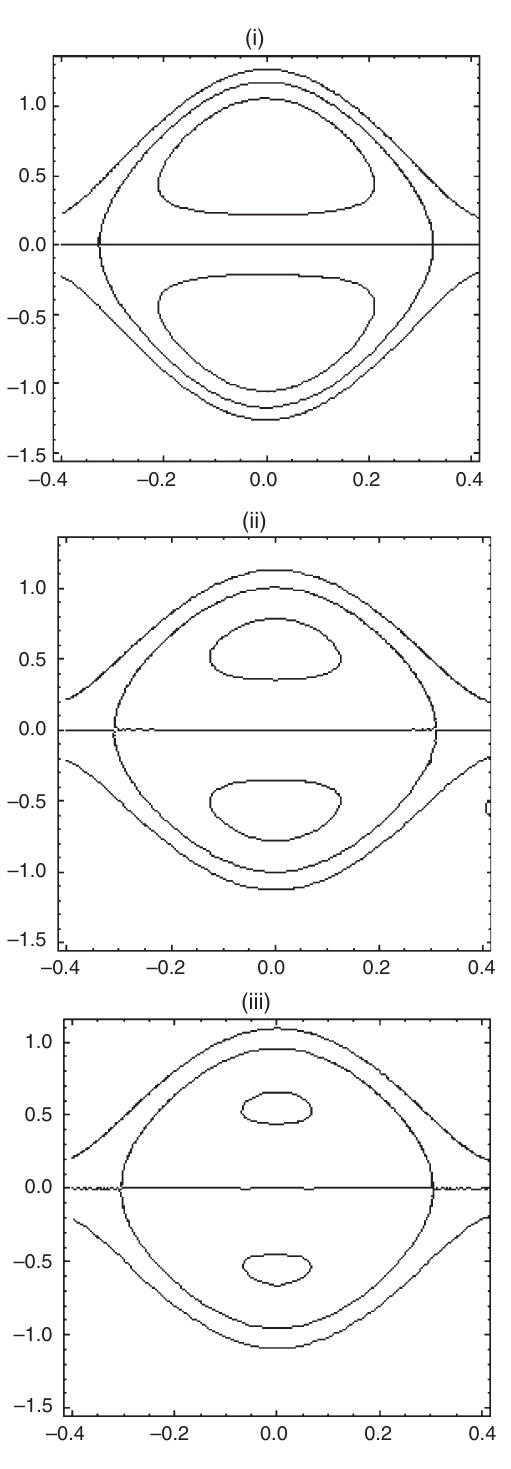
Fig. 10. Streamlines for a =0.5, b =0.5, d =1; Q = 1 . 4 and for dif- ferent β (i) β = 0 . 01, (ii) β = 0 . 1, (iii) β =